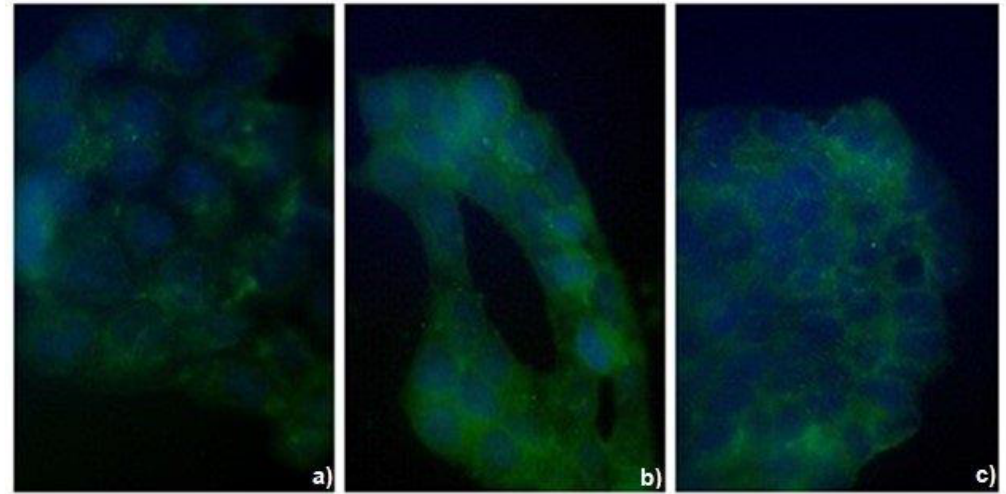
Figure 6. Protein expression of iNOS in HCT-116 control colorectal carcinoma cells a) and 24 h after treatments with 10 b) and 100 μg/mL c) O. minimum . The nuclei are colored blue (DAPI color), while iNOS is green (secondary antibody conjugated to Alexa